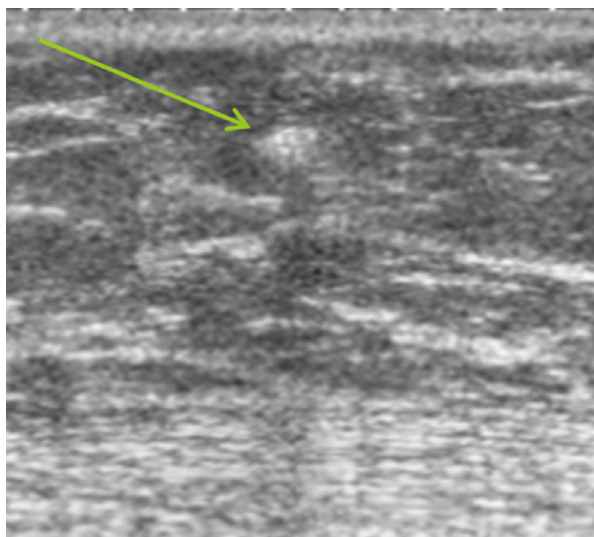
Fig. 18 Metastasis. Ultrasound showing a small hyperechoic, attenuating mass ( arrow ) in a patient followed for malignant melanoma. Cytological examination after ultrasound-guided fine-needle aspiration: very numerous spindle-shaped, pigmented, round malignant cells, corresponding to a metastasis from known malignant melanoma in this patient